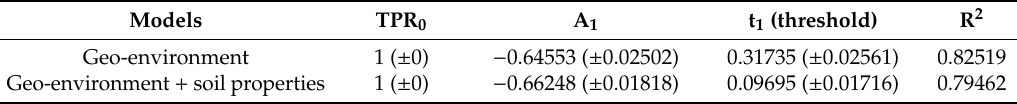
Table 8. Characteristics of the receiver operator characteristic (ROC) fitting curves exponential equation. Models